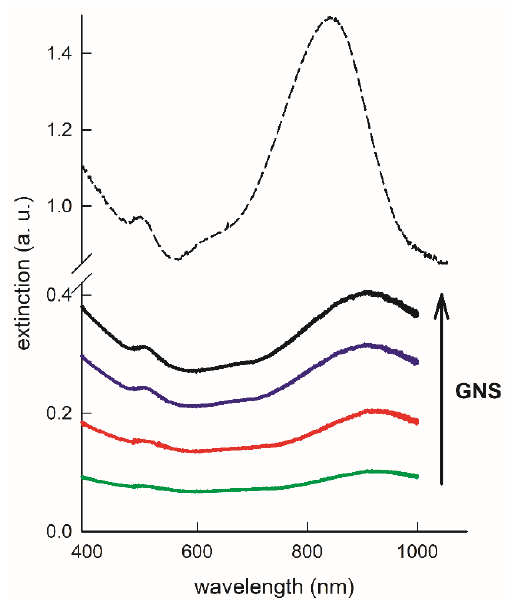
Figure 2. LSPR spectra of a colloidal suspension of coated GNS in EtOH (dashed line) and of four different PDMS samples with embedded coated GNS at increasing concentrations (solid lines, green: 0.9 × 10 − 6 ; red: 1.8 × 10 − 6 ; blue 2.7 × 10 − 6 ; black 3.6 × 10 − 6 mol Au/g of elastomer).